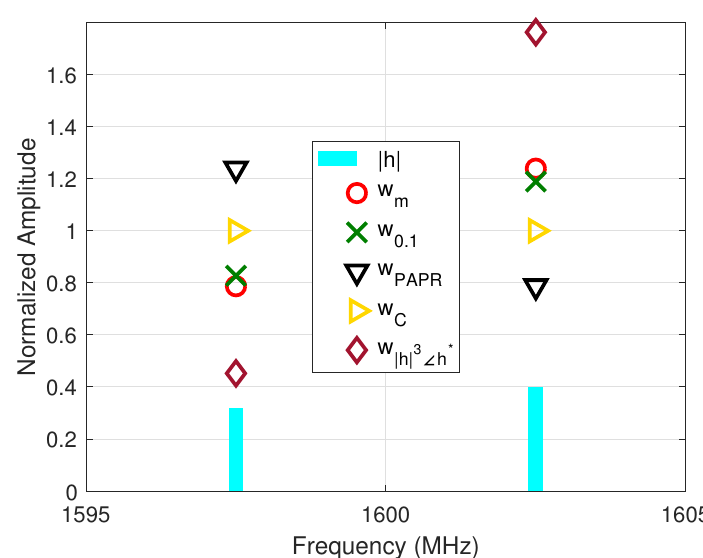
Figure 6. Normalized channel response amplitude and results of pre-equalizers w m , w PAPR , w C , w and balanced pre-equalizer with p = 0.1, for a SWIPT system using two-tone multisine signals | h | 3 (cid:54) h ∗ of 10